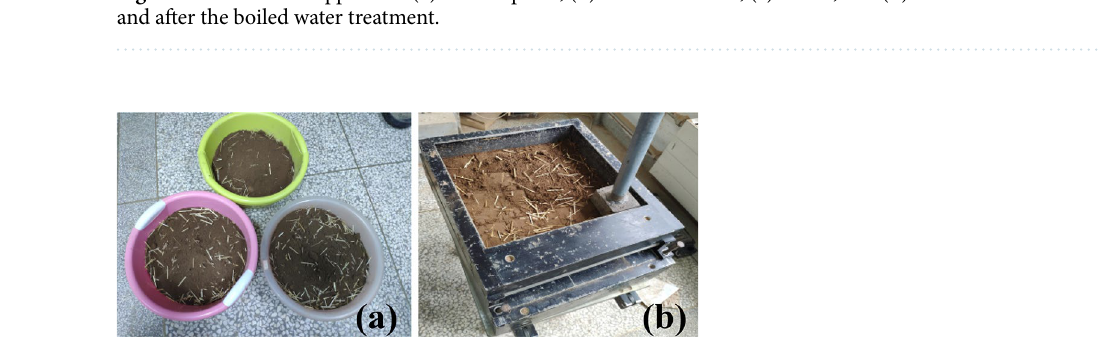
Figure 3. ( a ) loess-straw mixture and ( b ) reinforced specimen